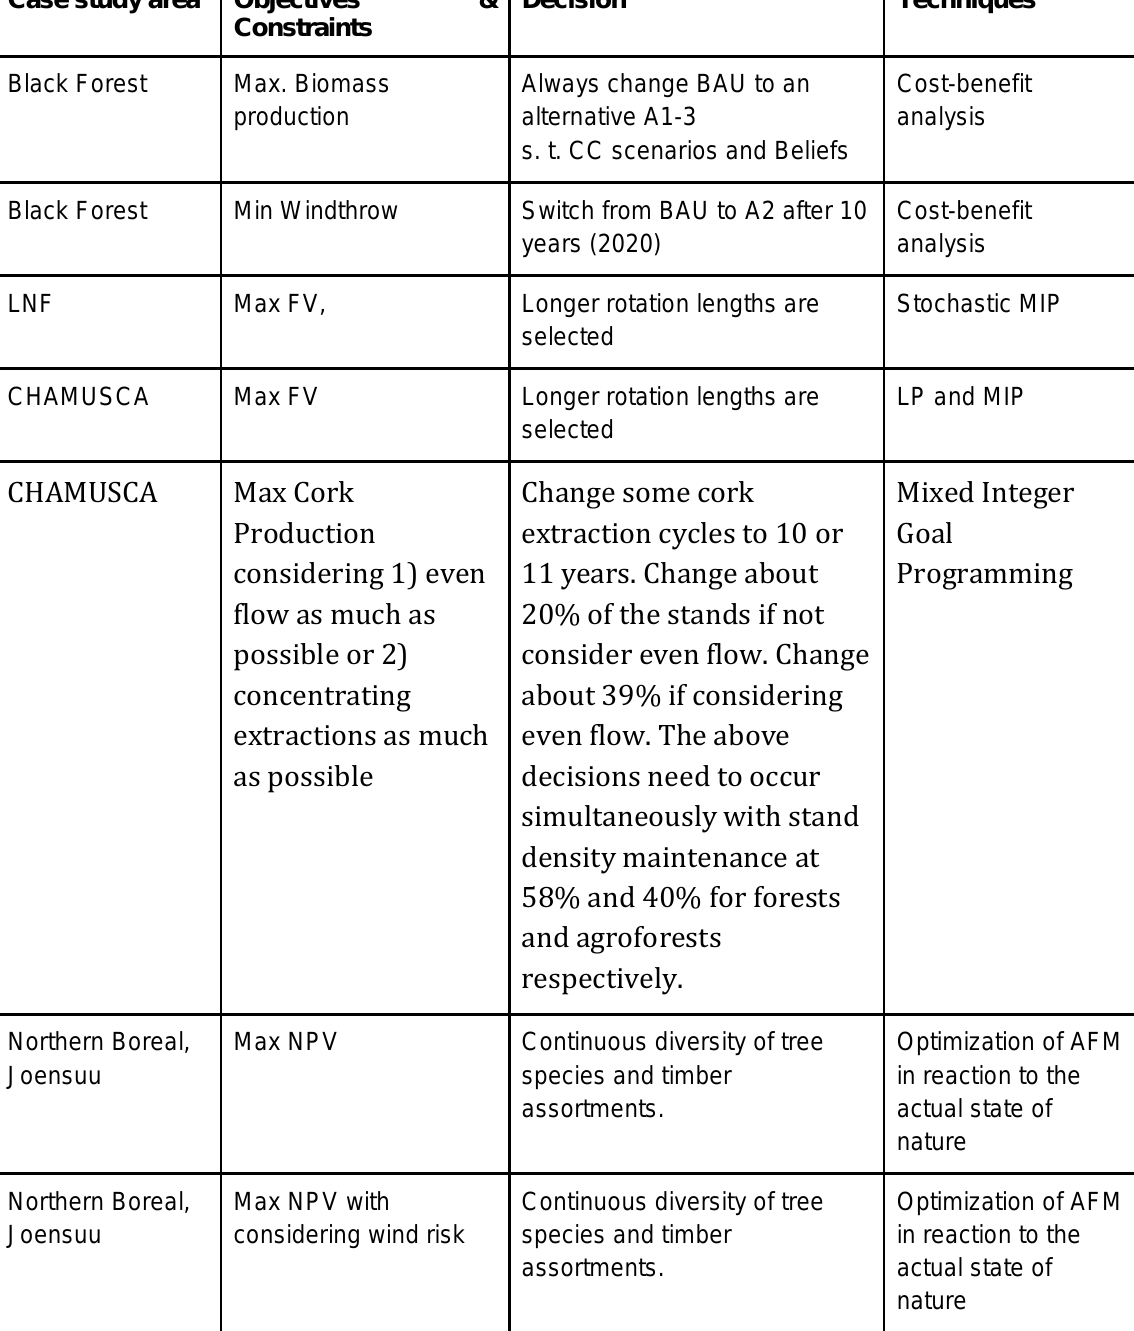
Table A4.1 Summary of management objectives, techniques and derived decisions on forest management strategies under climate